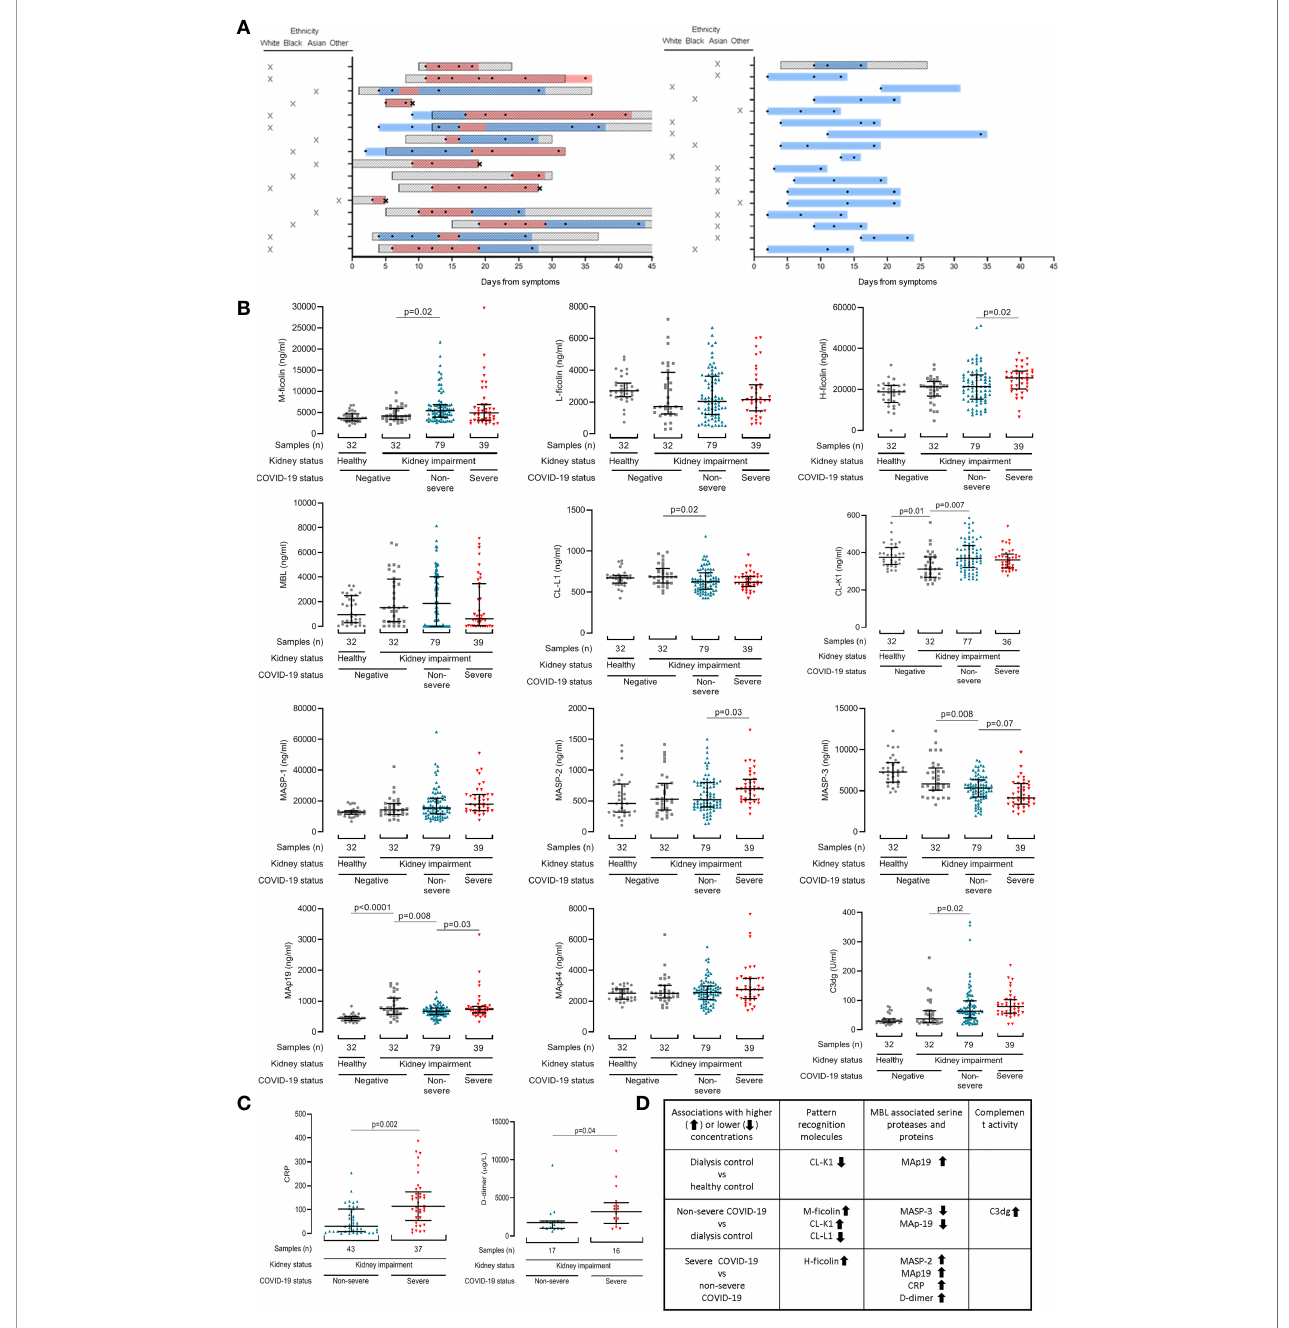
FIGURE 1 | Lectin pathway protein levels associate with COVID-19 severity in patients with chronic kidney impairment. (A) Schematic depicting blood sample collection in relation to symptom onset and disease severity. Each row represents one patient. Patients with severe COVID-19 infection are in the left panel, and those with non-severe COVID-19 infection in the right panel. The Y-axis also shows patient ethnicity. Boxed diagonal black lines represent hospital admissions. Two patients (C37 and C16) were hospitalised before developing COVID-19 symptoms. Sampling times are shown with black circles. Black crosses mark patient deaths. Coloured bars show when patients met criteria for severe (red) and non-severe (blue) COVID-19. (B) Lectin protein levels in 118 samples from 33 patients with COVID-19. 39 samples were from patients with severe (red triangles) and 79 samples were from patients with non-severe (blue triangles) COVID-19 at sampling. Controls are 32 dialysis patients without COVID-19 (dialysis control cohort, grey squares) and 32 healthy individuals (healthy control cohort, grey circles). (C) CRP and d-dimer levels in patients with kidney disease and COVID-19. Lines and whiskers show the median and interquartile values. Differences between cohorts were calculated with a mixed model for repeated measures and adjusted for multiple comparisons as described in the methods. (D) Summary of signi fi cant associations identi fi